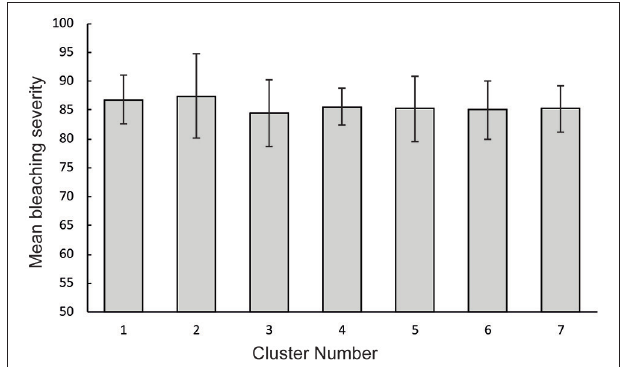
FIGURE 8 | Mean bleaching severity for different groups of Acropora species observed at Lizard Island. Groups were identified using hierarchical cluster analysis and error bars show standard